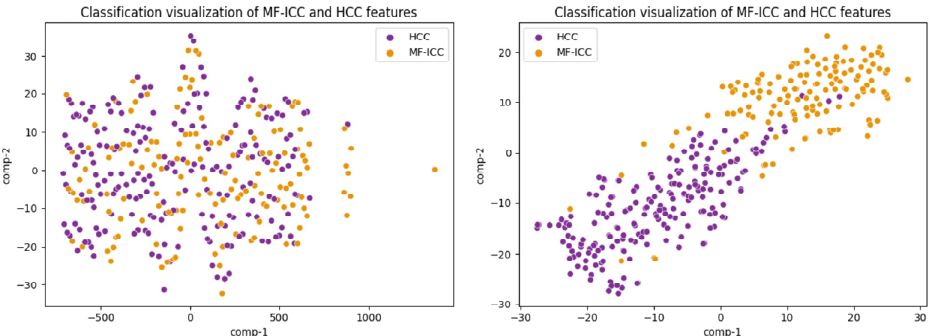
Figure 6. Feature separability of two categories (the left figure shows the original feature separability of the data, and the right figure shows the feature separability of the prediction set after classification by the SFFNet model; purple and yellow dots represent MF-ICC and HCC, respectively).